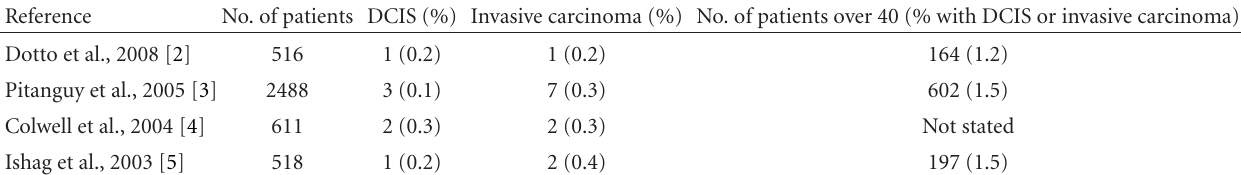
Table 3: Findings of cancer in bilateral reduction